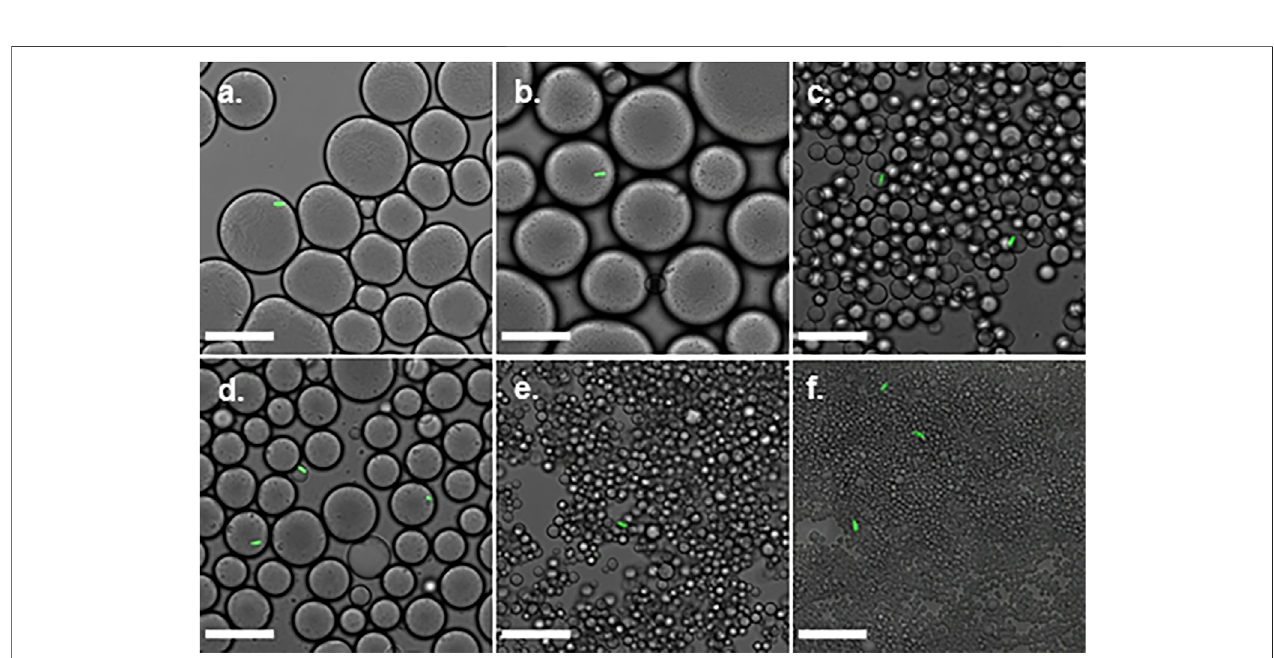
FIGURE 5 | Confocal microscopy images of single-cell encapsulation of 0.02% Triton X-100 Metarhizium brunneum Mb7-GFP conidia suspension in titania-NH 2 Pickering emulsion oil/water ratio. (A) 40:60, 0.4wt%. (B) 50:50, 0.4wt%. (C) 40:60, 1wt%. (D) 50:50, 1wt%. (E) 40:60, 2wt%. (F) 50:50, 2wt%. Scale bar is 30 μ m.